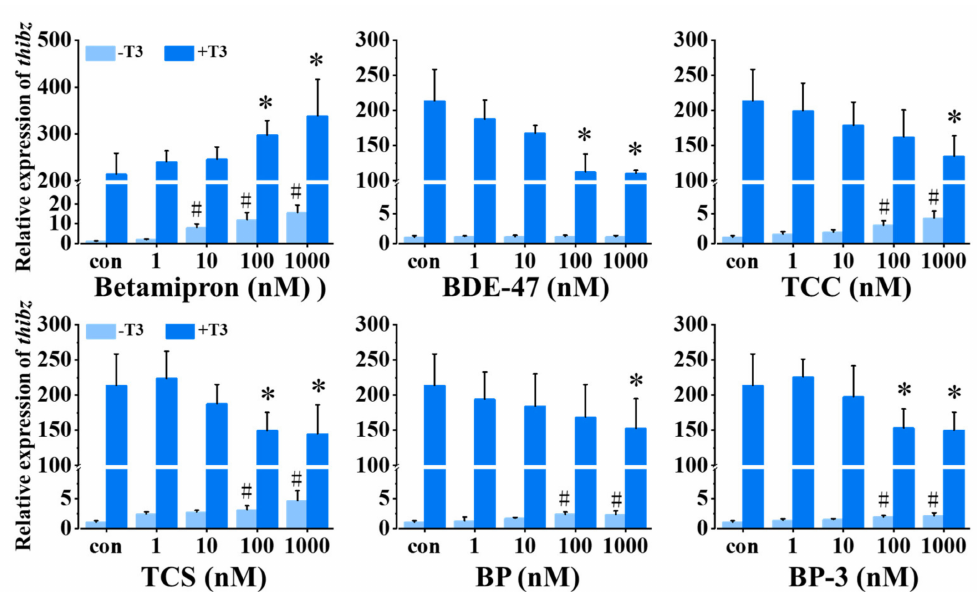
Figure 3. Relative expression of thibz (thyroid hormone induced bZip protein) in stage 48 Xenopus tadpoles following 24-h exposure to betamipron, 2,2 (cid:48) ,4,4 (cid:48) -tetrabromodiphenyl ether (BDE-47),